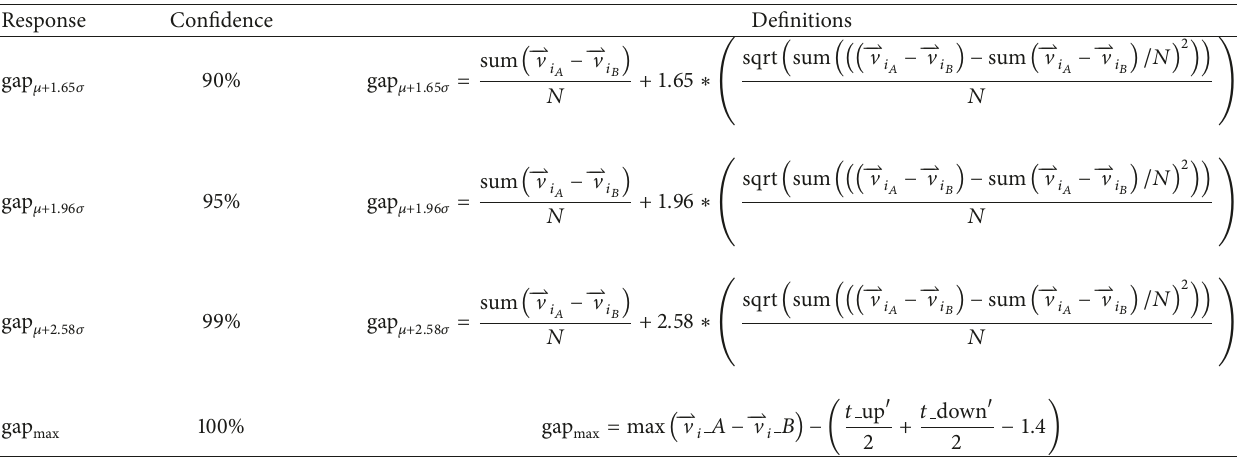
Table 8: Gap responses of different confidences.